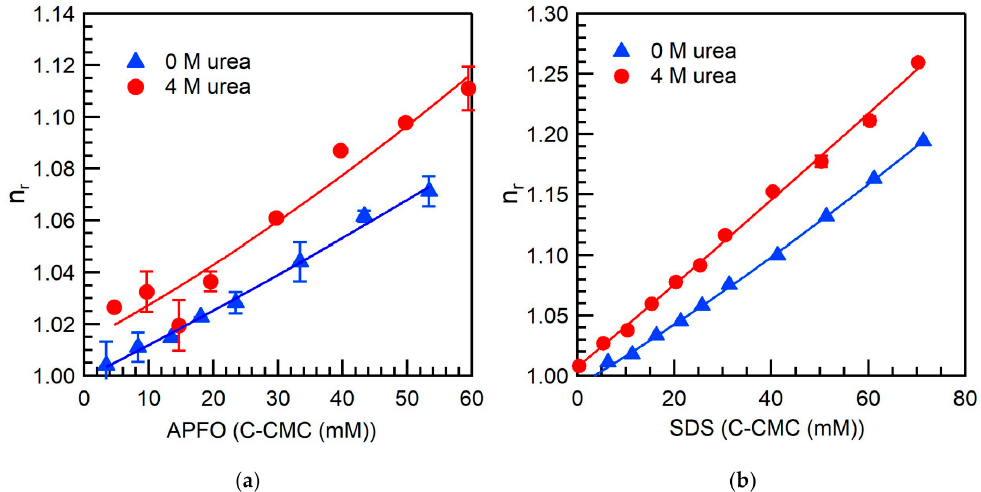
Figure 4. Relative viscosity, η r , of APFO ( a ) and SDS ( b ) aqueous solutions in the absence and in the presence of 4 M urea, plotted as a function of micellized surfactant concentration. The lines through the viscosity data points are fits to equation (6).